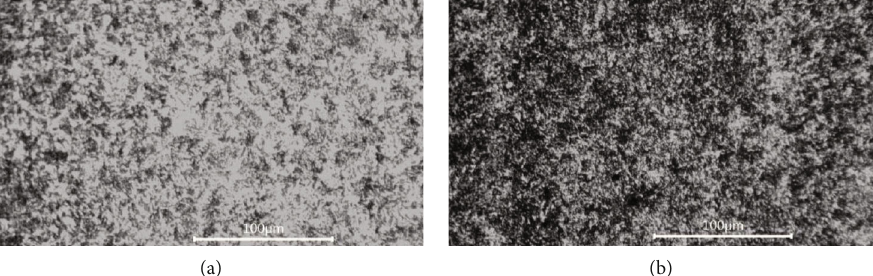
Figure 3: Microstructure of hardened 41Cr4 steel (400x magni fi cation): (a) without tempering; (b) after tempering at a temperature of 500 ° C.